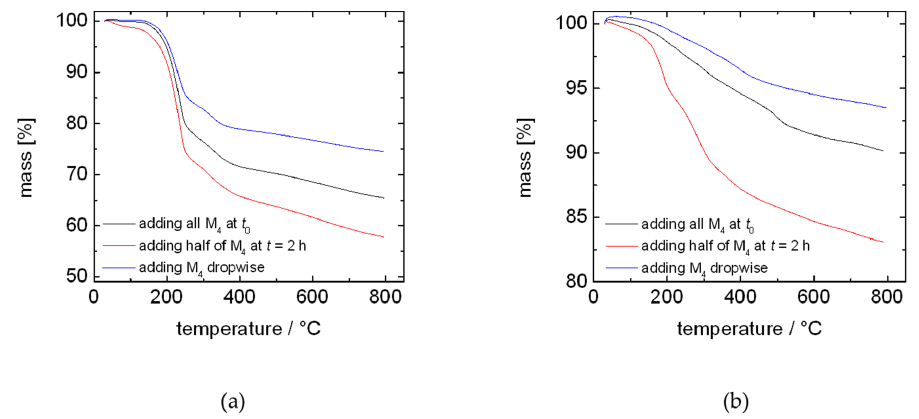
Figure 7. TGA for ( a ) PDMS@SiO 2 and ( b ) PDMS@SiO 2 @Fe 2 O 3 synthesized with different injection